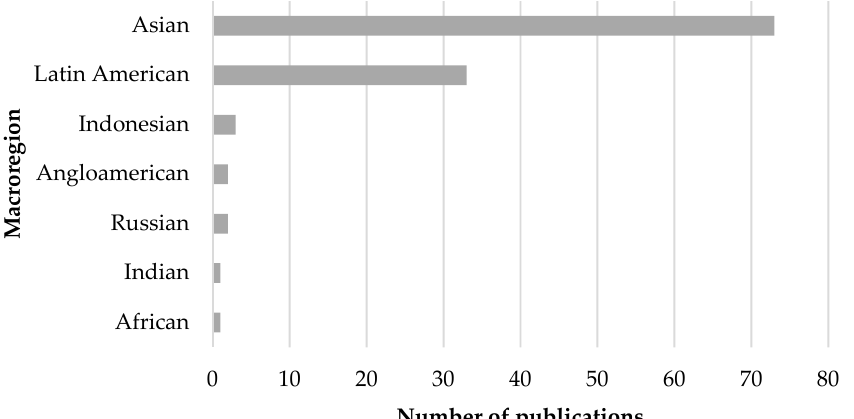
Figure 2. Geographical distribution of publications focusing on irrigation-induced landslides, fol- lowing the global macroregional classification defined by Ande ̌ l et al. [49] and the scientific litera- ture published in Chinese, English, and Spanish.